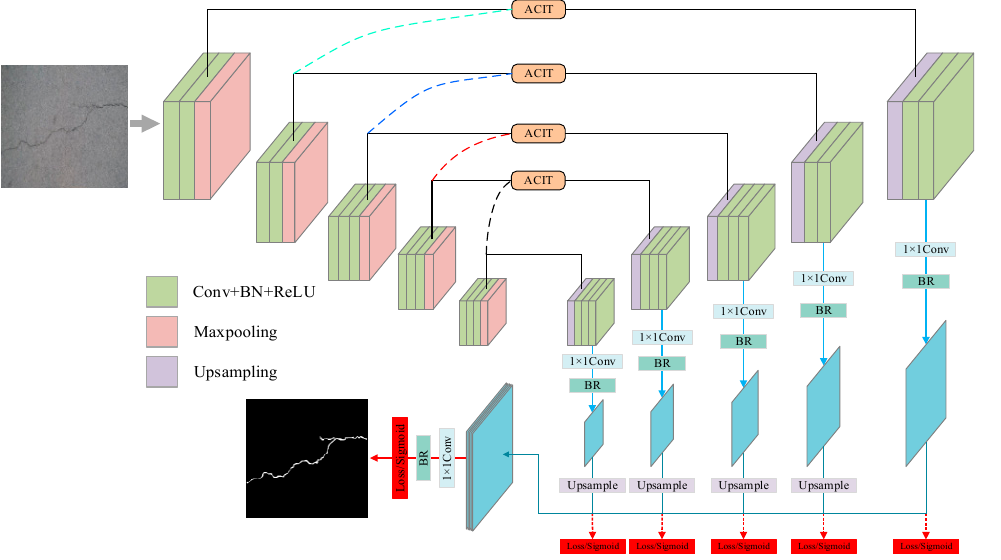
Figure 3. The architecture of CTCD-Net. The three main parts are as follows: (1) a SegNet architec- ture with side outputs, (2) four attention-based cross-layer information transmission (ACIT) mod- ules, and (3) six boundary refinement (BR) blocks.